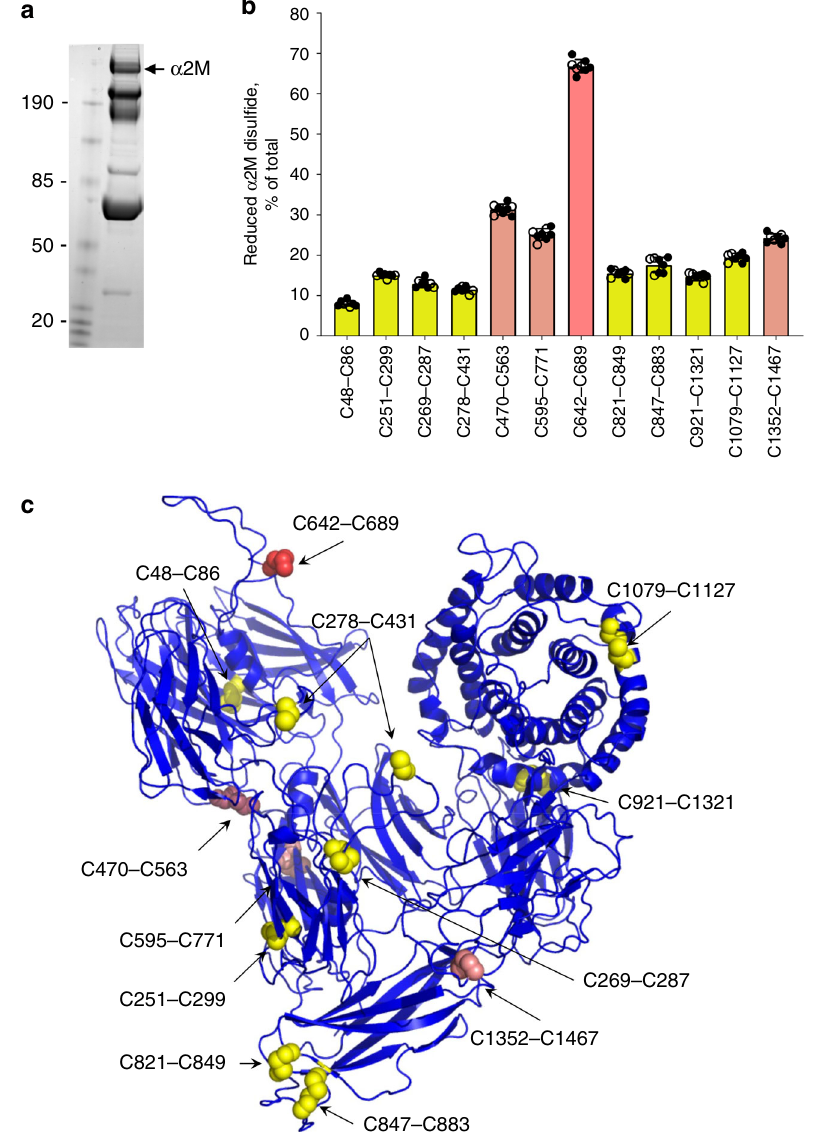
Fig. 6 α 2-Macroglobulin also exists in multiple disul fi de-bonded states in the circulation. a α 2-Macroglobulin was isolated and processed from the same healthy donor plasmas as described for fi brinogen in Fig. 1. Shown is a representative 12 C-IPA-labeled α 2-macroglobulin resolved on SDS-PAGE. Molecular mass standards are shown in the left-hand lane. α 2-Macroglobulin is a homo-tetramer with a molecular mass of 720 kDa. b Redox states of the 12 α 2- macroglobulin disul fi de bonds in eight healthy human donors ( fi ve female — solid symbols; three male — open symbols). The bars and errors are mean ± SD. Bonds indicated by yellow bars are <20% reduced, salmon bars 20 – 40% reduced and the red bar >40% reduced. Source data are provided as a Source Data fi le. c Ribbon structure of α 2-macroglobulin and the positions of the 12 disul fi de bonds (spheres) 19 (PDB identi fi er 4acq). The disul fi de colour matches the coding in part B. The C278-C431 disul fi de is cleaved in this structure, while the other 11 disul fi de bonds are